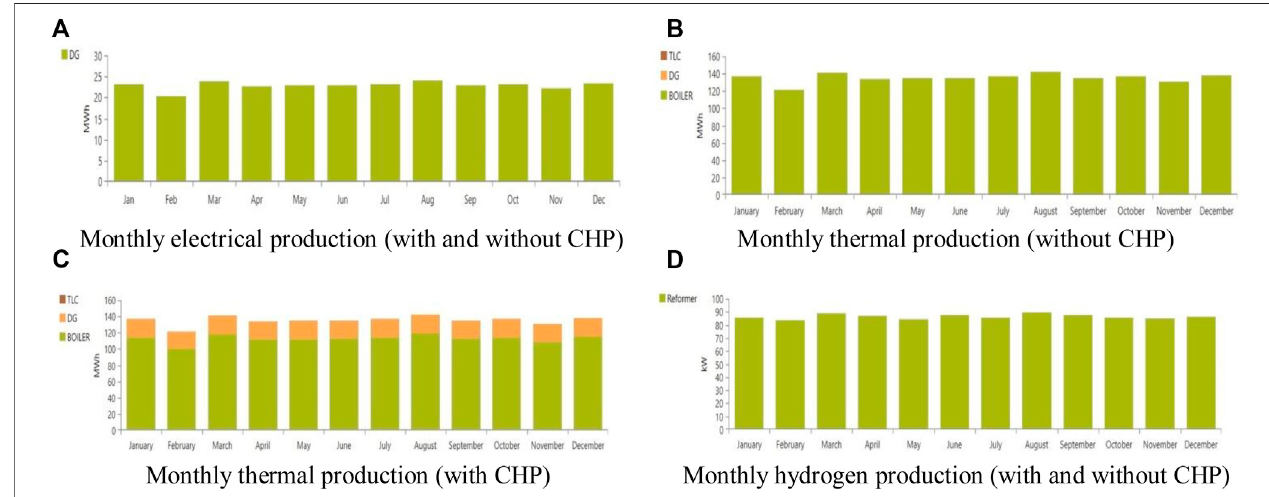
FIGURE 6 | Monthly energy productions. (A) Monthly electrical production (with and without CHP). (B) Monthly thermal production (without CHP). (C) Monthly thermal production (with CHP). (D) Monthly hydrogen production (with and without CHP).